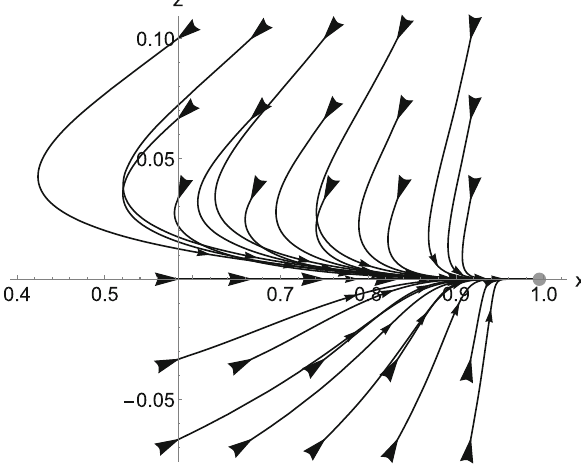
Fig. 5 The evolution towards the A cosmological solution in the { x , z } plane